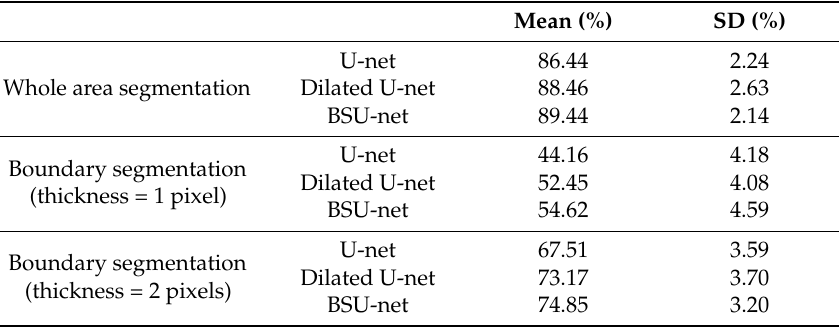
Table 1. Dice similarity coefficient (DSC) measurements for the three different models. Accuracy for boundary area is very limited.